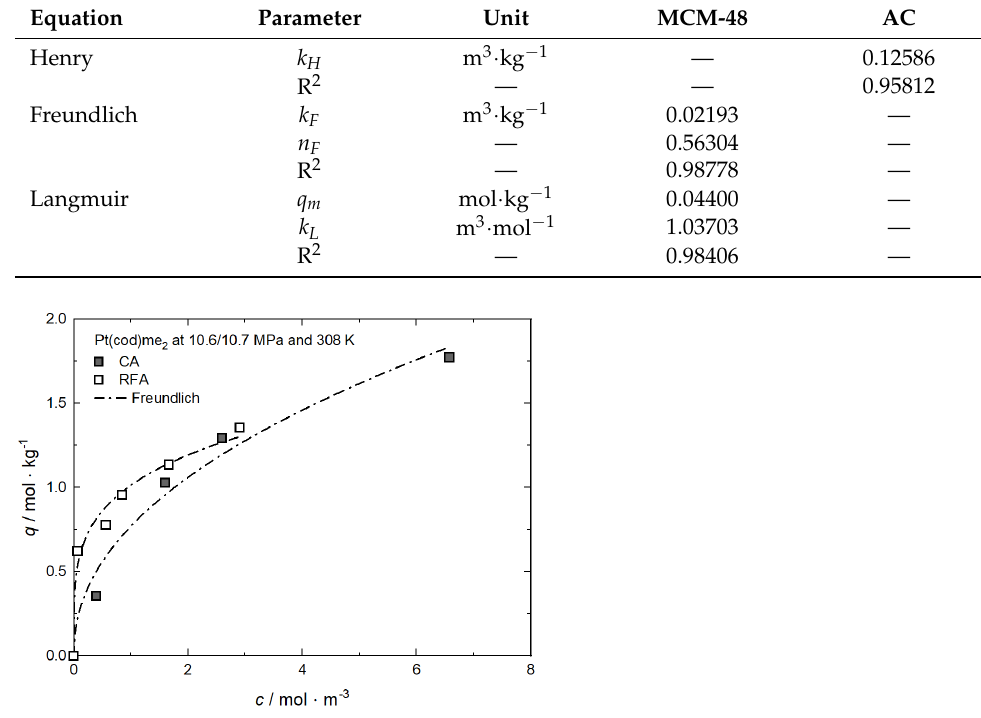
Figure A16. Uptake of Pt(cod)me 2 at 10.6/10.7 MPa and 308 K on different substrates; experimental data taken from [10,58]. Table A16. Adsorption isotherm parameters for Pt(cod)me 2 from scCO 2 solution at 10.6/10.7 MPa and 308 K on different substrates [10,58].